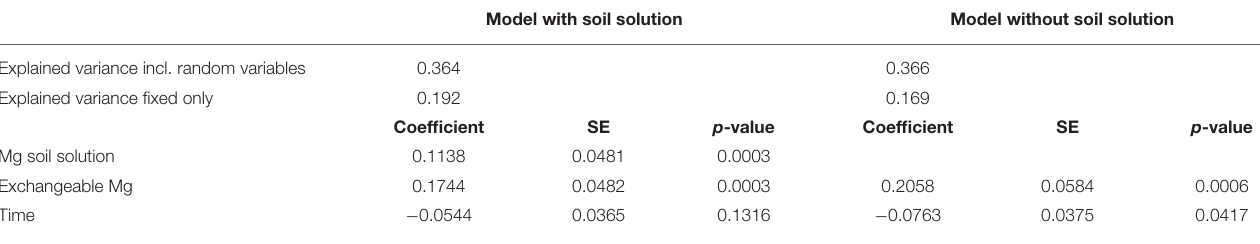
TABLE 3 | Regression coefficients for the relation between foliar nutrient concentrations with Mg concentration in soil solution (line 3), exchangeable Mg concentration in the soil (line 4), and time (line 5), for regression models including (left) and excluding Mg in soil solution. Model with soil solution Explained variance incl. random